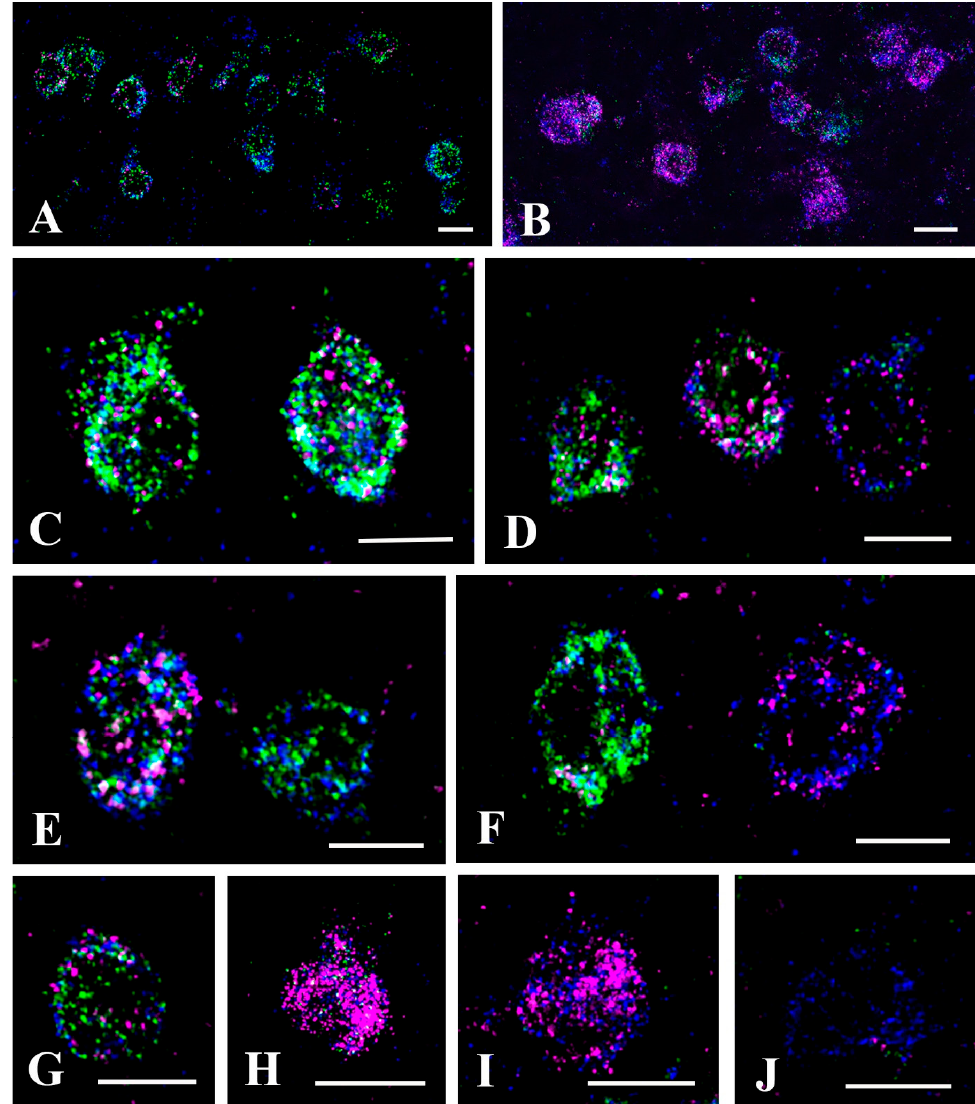
Figure 5. Expression of tdTomatomo, GlyT2, and GAD65/67 mRNA in the lumbar spinal dorsal horn of Pax2:Cre-tdTomato mice. Micrograph of 3 µm thick confocal optical sections obtained from the L4–5 levels of the spinal dorsal horn of Pax2:Cre-tdTomato mice and hybridized for tdTomato (blue), GlyT2 (magenta) and GAD65/67 (green) mRNA. The hybridization end products appear as small dots within the con fi nes of individual neurons. Triple labeling images are shown at low ( A , B ) and high ( C – J ) magni fi cations. The images are of laminae I–III ( A , C – E , G , J ) and lamina IV ( B , F , H , I ) of the dorsal horn. Not that most of the neurons are triple labeled, but there are some that are neg- ative for GlyT2 ( E ) or GAD 65/67 ( F , I ) or both GlyT2 and GAD 65/67 ( J ) mRNA. Bars: 20 µm.